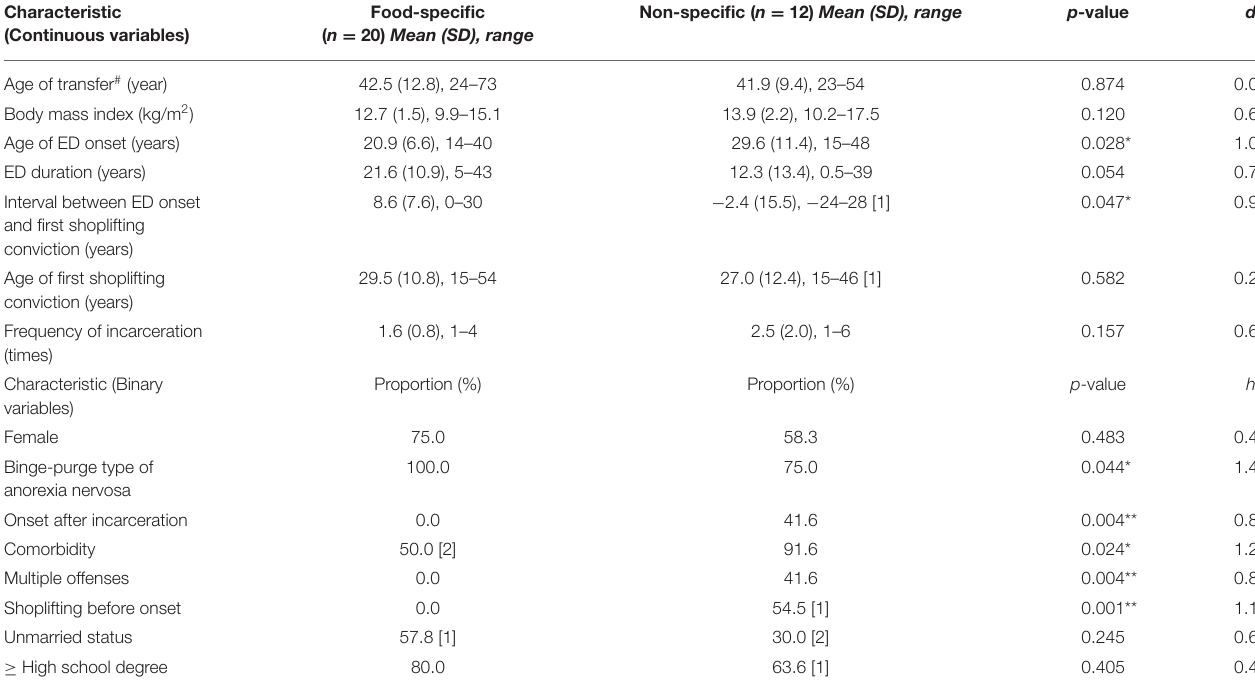
TABLE 1 | Comparison of characteristics between food-specific shoplifting and non-specific shoplifting groups. Characteristic (Continuous variables)